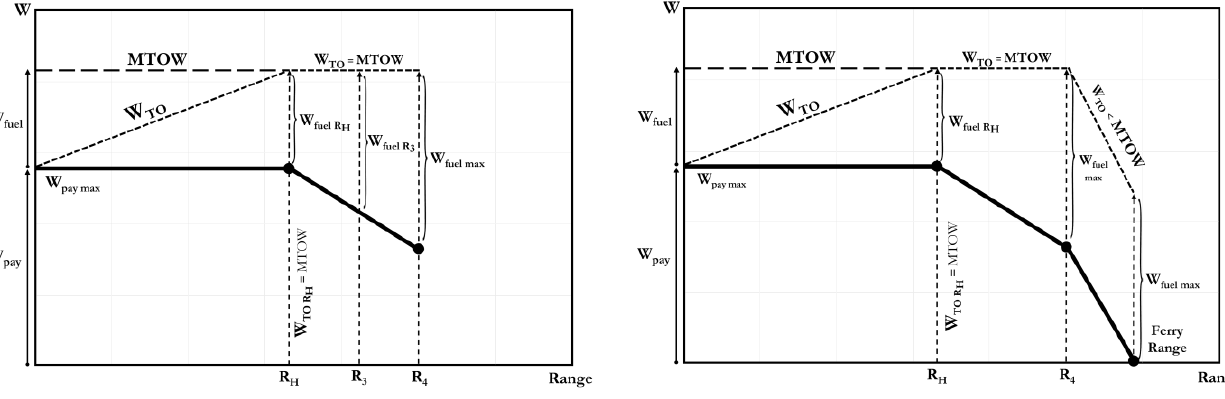
Figure 15. Payload – range diagram for a conventional thermal powered aircraft — Part 2. Figure 15. Payload–range diagram for a conventional thermal powered aircraft—Part